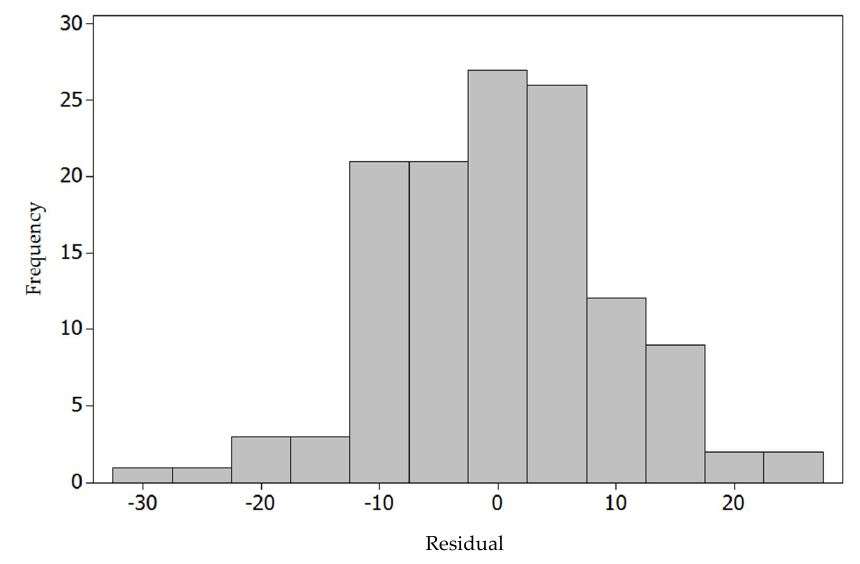
Figure 12. Histogram of residuals associated with selected standardized effects.